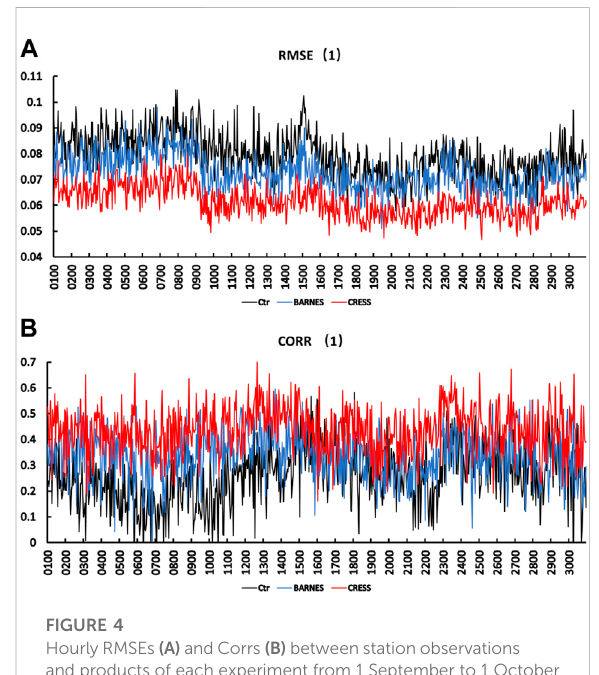
FIGURE 4 Hourly RMSEs (A) and Corrs (B) between station observations and products of each experiment from 1 September to 1 October 2020, including Ctr (black lines), BARNES (blue lines), and CRESS (red lines).